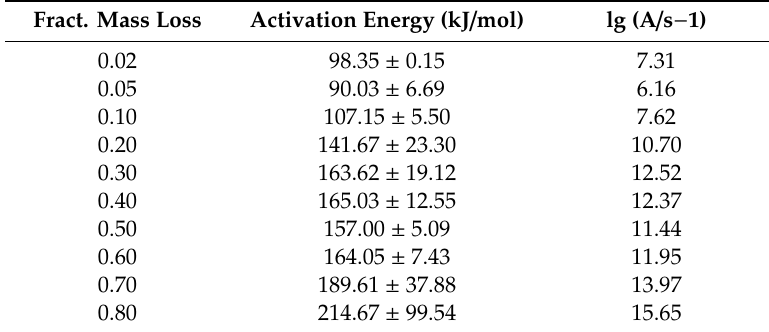
Table A1. Activation energy and pre-exponential coefficient as a function of the degree of conversion by the Friedman method for a maize straw sample.